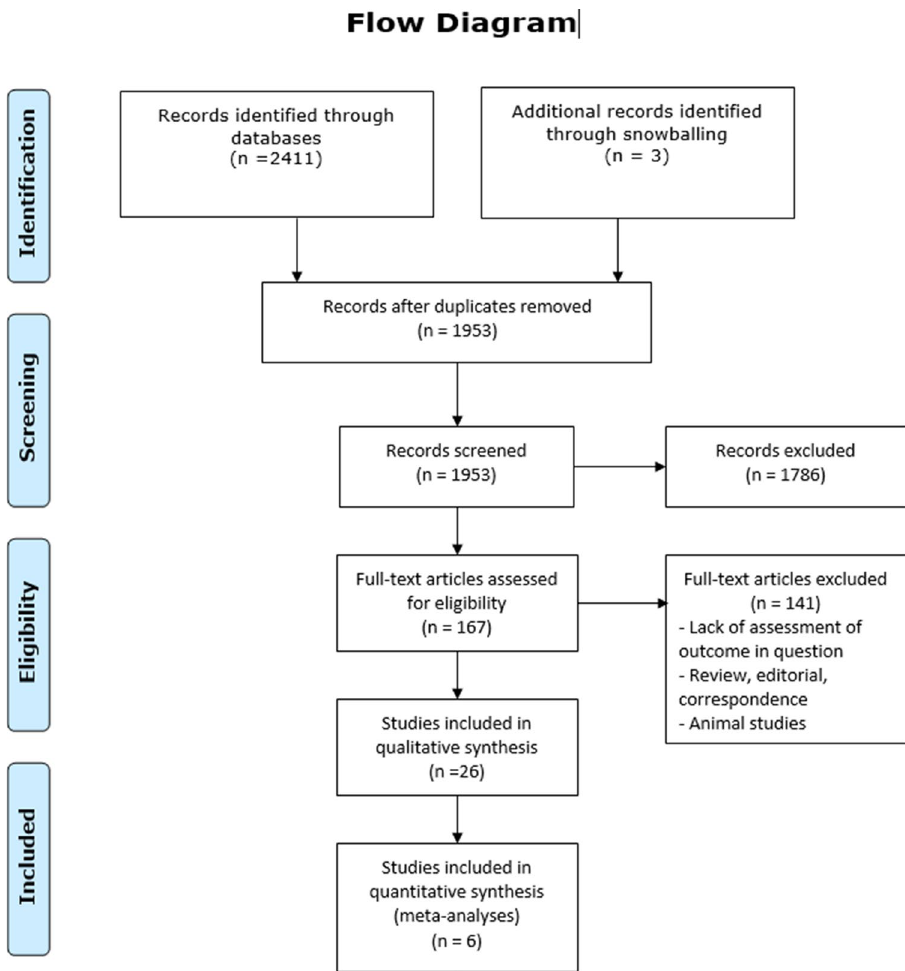
Figure 1. Flow chart of the study selection